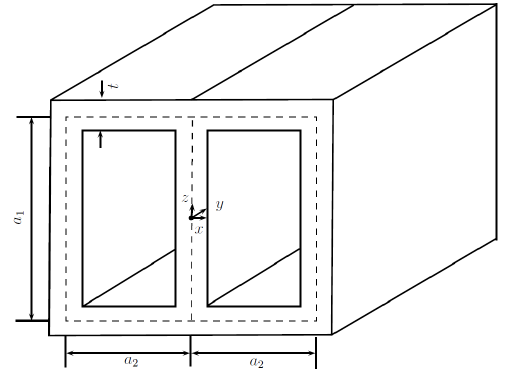
Figure 14. Distribution of axial and shear stress components for P ∗ = − 3.0 − 3 values in L9 for the FG beam subjected to axial loading for m = 5.0, and P ∗ 30 ( σ ∗ yy = σ yy / σ yy and σ ∗ yz = σ yz / σ yz at x = − a 2 /2 and y = L /2). max max